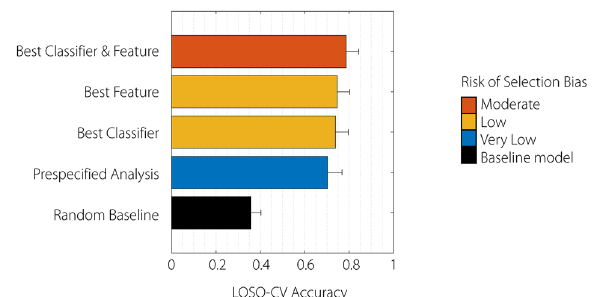
Fig. 2 Primary outcome (any-rater criterion). The mean leave-one- subject-out cross-validation (LOSO-CV) classi fi cation accuracy of the smartphone-based prediction of the blinded MDS-UPDRS III. The accuracy of a number of approaches is compared to a random baseline (similar to rolling a dice where subjects were randomly assigned to a clinical category). The fully pre-speci fi ed analysis (blue) relied on pre-published features and a standard multinomial regression model. The Best Classi fi er approach selected the best classi fi er from a range based on best performance but used only the pre-speci fi ed features. The Best Feature approach selected the best feature from a range but used only the pre-speci fi ed classi fi er. The Best Classi fi er and Feature approach selected the best combination of both. Approaches are graded according to the risk of selection bias: the pre-speci fi ed analysis has a very low risk, the Best Classi fi er or Best Feature analyses have low risk whilst the combination approach has a moderate risk of over-optimistic accuracy. Error bars represent